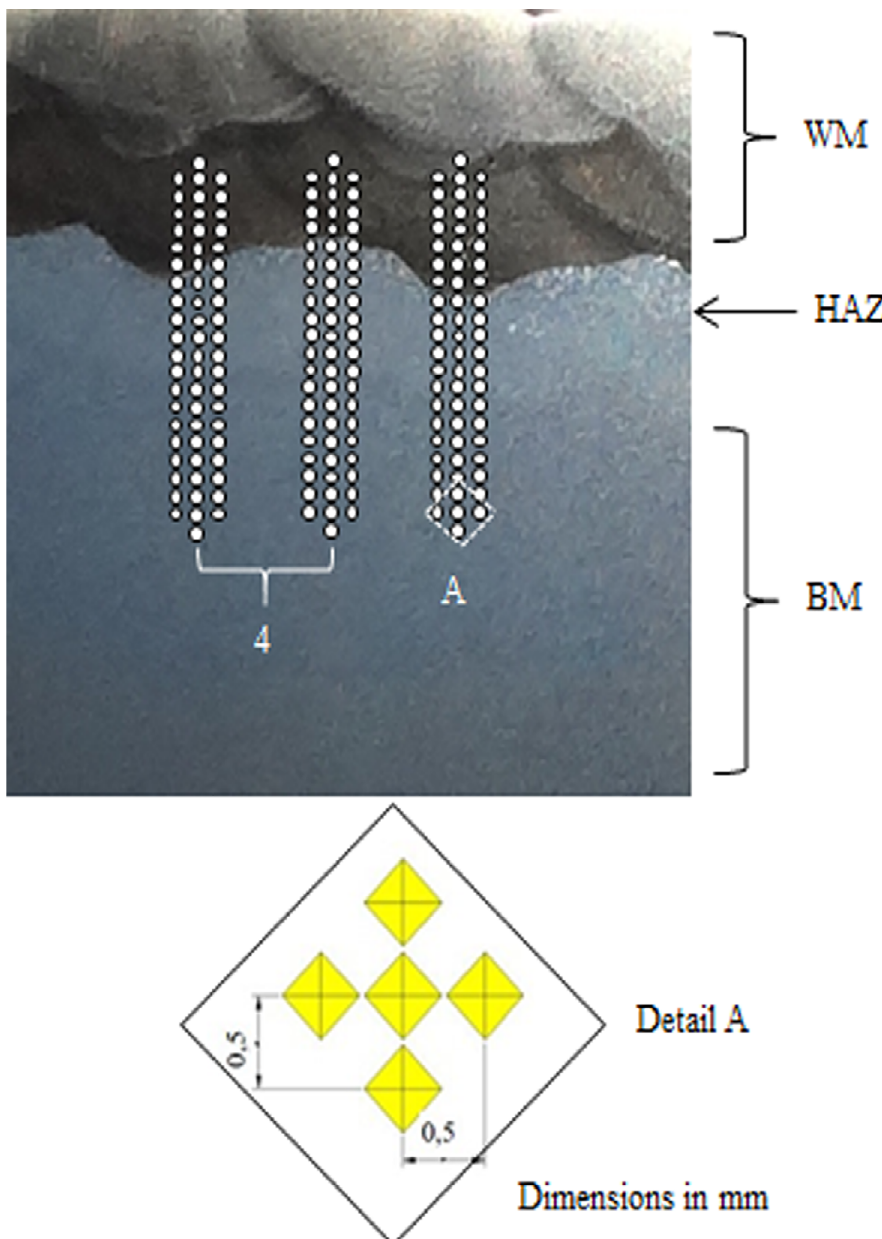
Figure 2. Distribution of indentations in the microhardness